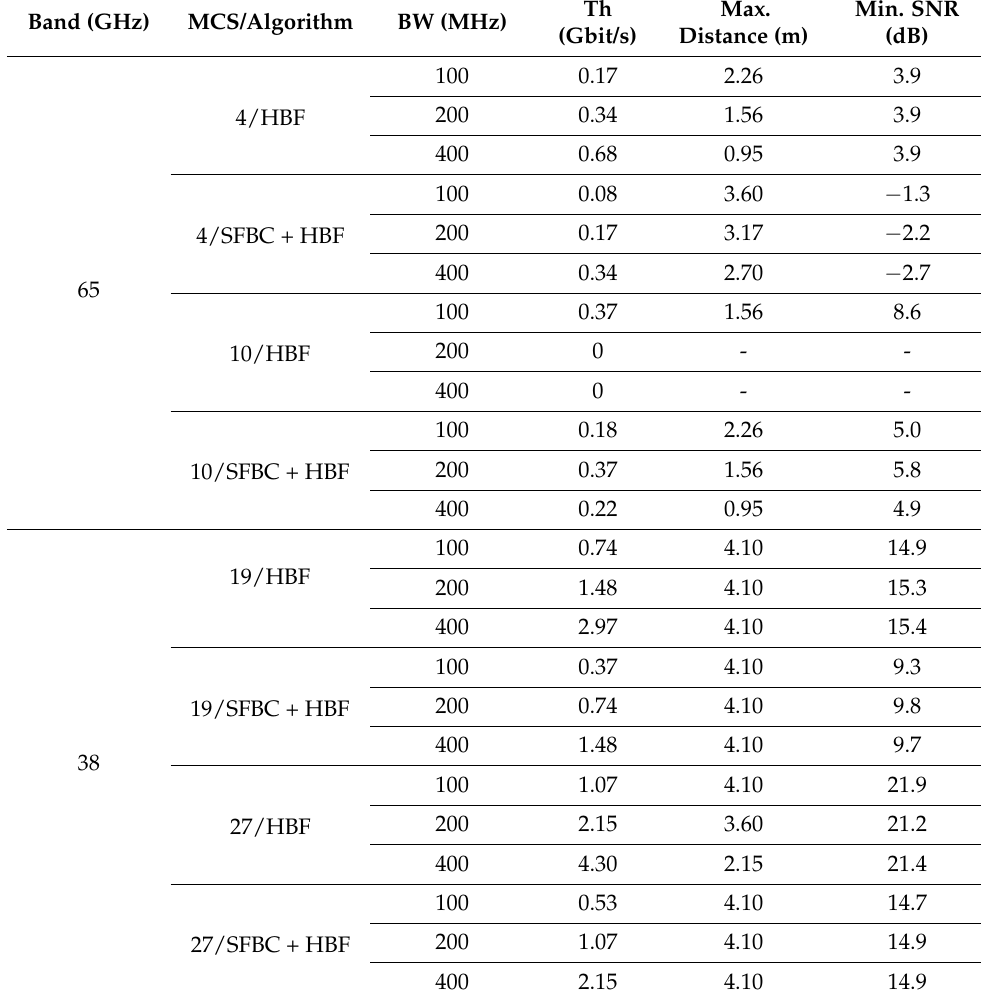
Table 6. Comparison between HBF and SFBC +